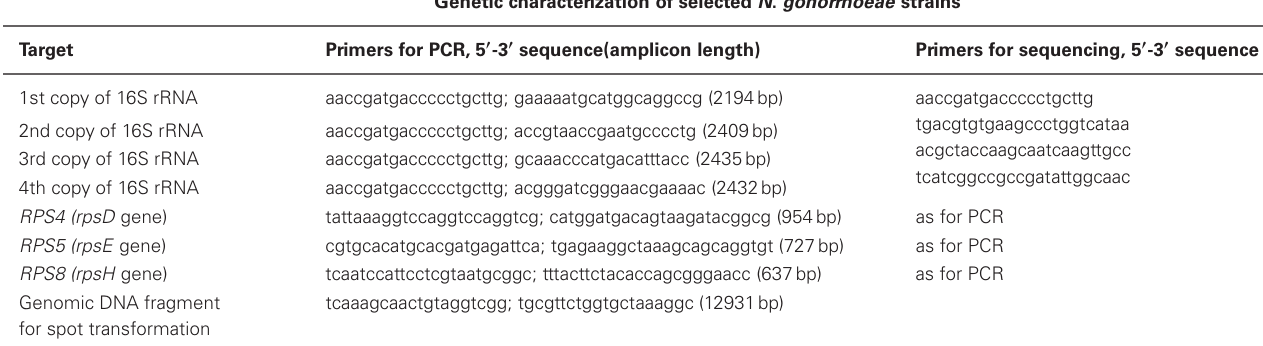
Table 2 | List of primers selected for PCR and sequencing of N. gonorrhoeae genes encoding 16S rRNAs, and ribosomal proteins S4, S5, and S8. Genetic characterization of selected N . gonorrhoeae strains